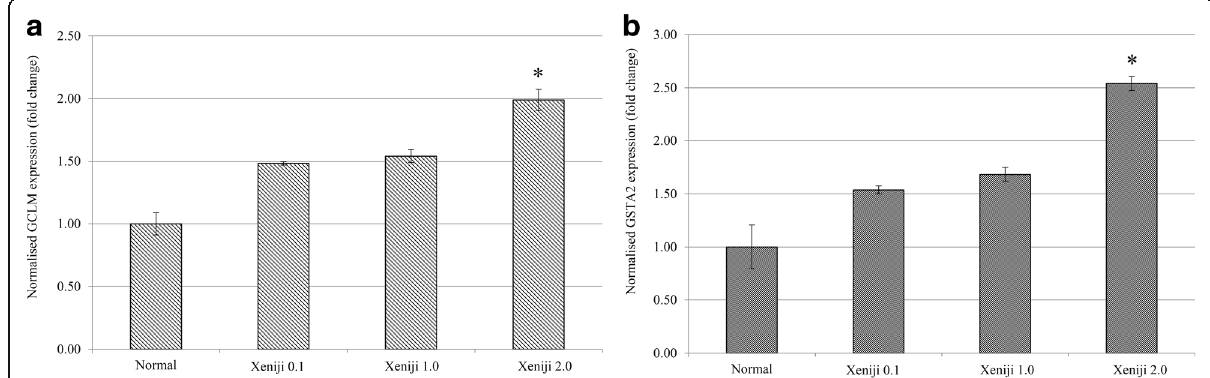
Fig. 1 Differential expression of ( a ) GCLM and ( b ) GSTA2 genes related to Nrf-2 antioxidant pathway on normal and Xeniji (0.1, 1 and 2 g/kg body weight) treated mice. The expression of target genes (±SEM) were normalised to β -actin and the normal group was used as control for comparison. Fold change >2 comparing to normal control group was considered as